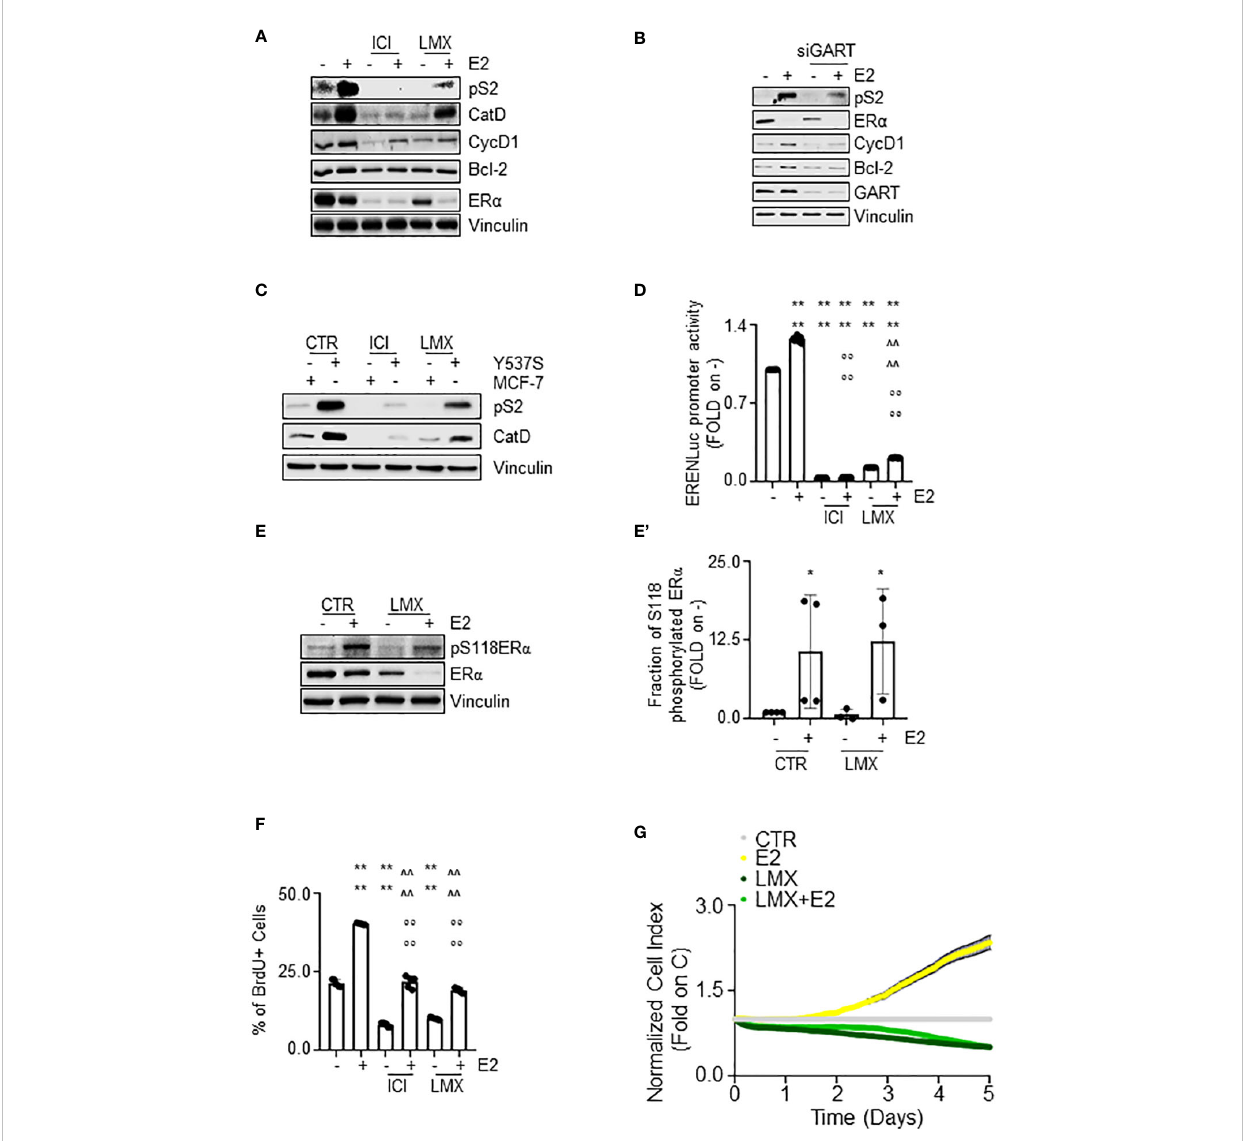
FIGURE 6 The impact of GART inhibition on E2:ER a signaling to cell proliferation. (A) Western blot of presenilin 2 (pS2), cathepsin D (CatD), cyclin D1 (CycD1), Bcl-2, and ER a expression levels in MCF-7 cells pre-treated with lometrexol (LMX 1 µM) for 48 hours and then treated for 24 hours with 17 b - estradiol (E2 - 10 nM). The loading control was done by evaluating vinculin expression in the same fi lter. Panels show representative blots. Densitometric and statistical analyses are reported in Supplementary Figures 3A – E. (B) Western blot of presenilin 2 (pS2), cyclin D1 (CycD1), Bcl-2, and ER a expression levels in MCF-7 cells pre-treated with GART siRNA oligonucleotides for 24 hours and then treated for 24 hours with 17 b - estradiol (E2 - 10 nM). The loading control was done by evaluating vinculin expression in the same fi lter. Panels show representative blots. Densitometric and statistical analyses are reported in Supplementary Figures 3F – I. (C) Western blot of presenilin 2 (pS2), and cathepsin D (CatD) in MCF-7 and Y537S cells treated with lometrexol (LMX 1 µM) for 48 hours. The loading control was done by evaluating vinculin expression in the same fi lter. Panels show representative blots. Densitometric and statistical analyses are reported in Supplementary Figures 4A, B. (D) Estrogen response element promoter activity in MCF-7 ERE-NLuc cells pre-treated with fulvestrant (ICI182,780 - ICI 100 nM) or lometrexol (LMX 1 µM) for 48 hours and then treated with 17 b -estradiol (E2 10 nM) for additional 24 hours. The experiments were performed three times in quintuplicate. Signi fi cant differences were calculated with the Anova test. **** ( p-value < 0.0001) indicates signi fi cant differences with respect to untreated ( i.e. , -) sample. °°°° ( p-value < 0.0001) indicates signi fi cant differences with respect to E2 treated sample. ^^^^ ( p-value < 0.0001) indicates signi fi cant differences with respect to LMX treated sample. Western blot (E) and relative densitometric analyses (E ’ ) of ER a and ER a S118 phosphorylation expression levels in MCF-7 cells pre-treated with lometrexol (LMX 1 µM) for 48 hours and then treated for 30 min with 17 b -estradiol (E2 -10 nM). The loading control was done by evaluating vinculin expression in the same fi lter. Panels show representative blots of 4 independent experiments. Signi fi cant differences with respect to - sample are calculated by Student t-test and indicated by * p -value < 0.05. (F) Bromodeoxyuridine (BrdU) incorporation assay in MCF-7 cells treated with 17 b -estradiol (E2 10 nM – 24 hours) after 48 hours pre-treatment with lometrexol (LMX 1 µM). The experiments have been performed twice in duplicate. Signi fi cant differences were calculated with the Anova test. **** ( p-value < 0.0001) indicates signi fi cant differences with respect to untreated ( i.e. , -) sample. °°°° ( p-value < 0.0001) indicates signi fi cant differences with respect to E2 treated sample. ^^^^ ( p-value < 0.0001) indicates signi fi cant differences with respect to LMX treated sample. (G) Real-time growth curves in MCF-7 cells treated with lometrexol (LMX 1 µM) in the absence and the presence of 17 b -estradiol (E2 10 nM). The graphs show the normalized cell index ( i.e. , cell number), which is detected with the xCelligence DP device and calculated at each time point with respect to the control sample. Each sample was measured in quadruplicate. For details, please see the material and methods